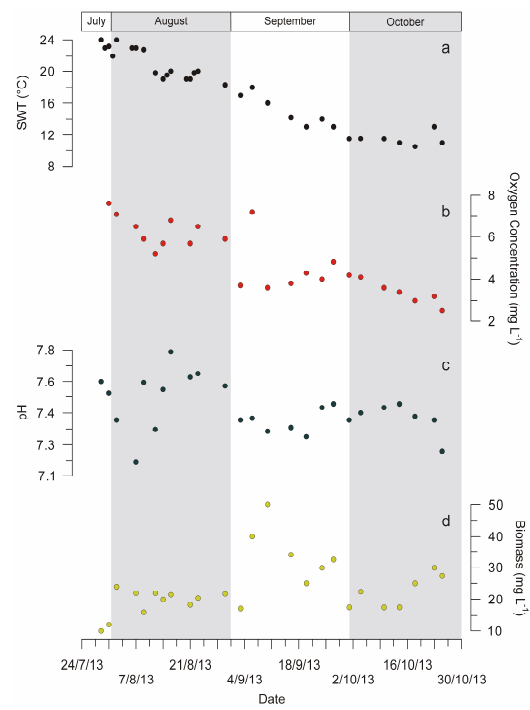
Figure 2. (a) Surface water temperature (SWT), (b) oxygen concen- tration, (c) pH and (d) amount of phytoplankton biomass measured in Lake Schreventeich from late July until the end of October